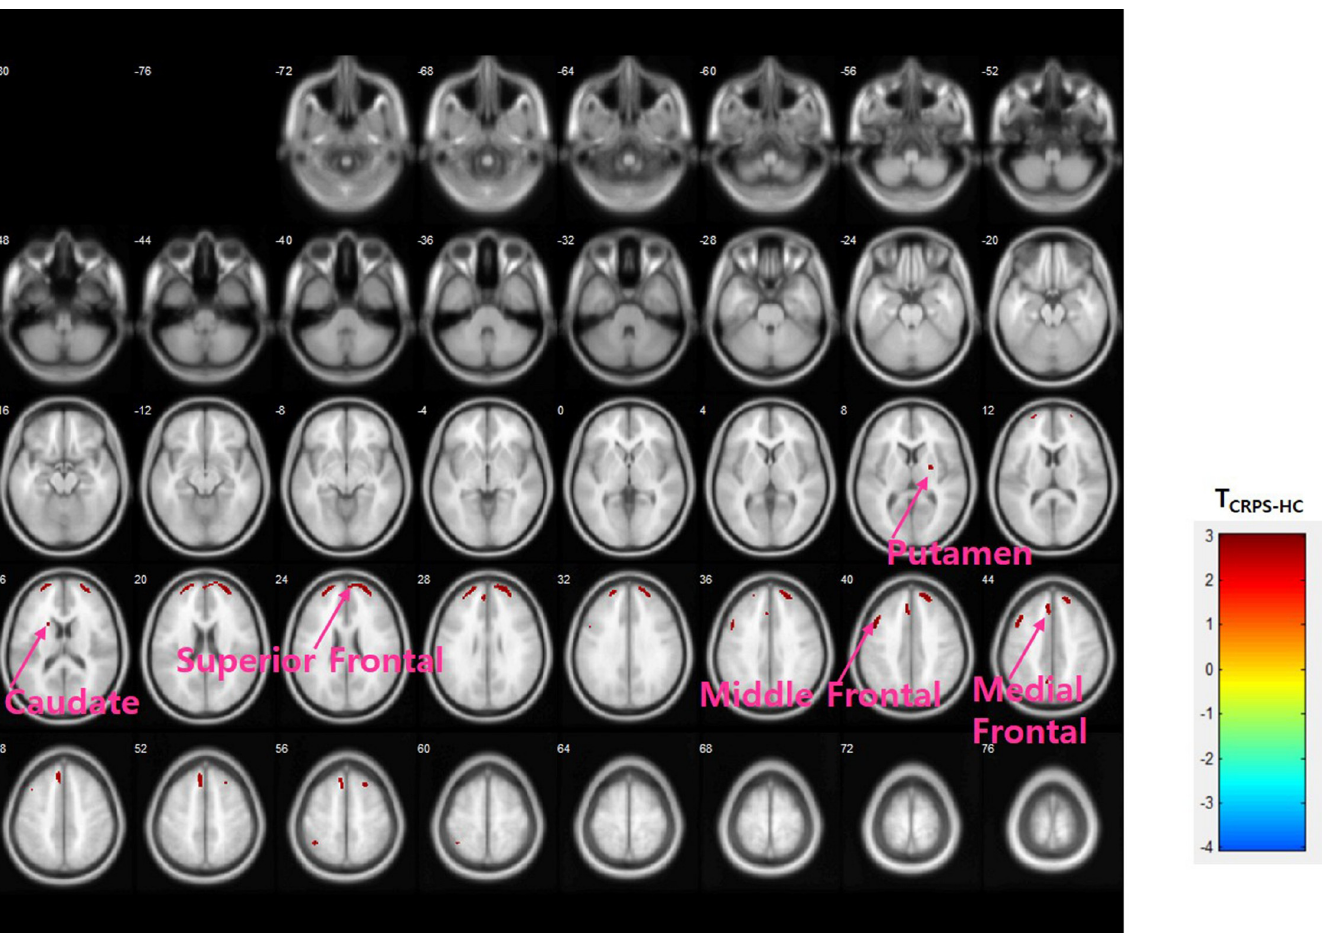
Fig 2. Differences in [ 11 C]-(R)-PK11195 DVR between CRPS patients and healthy controls. Analysis of covariance (ANCOVA) with duration covariate, uncorrected p < 0.01. other hand, higher binding levels in the CRPS group were observed in the medulla, left insula, left thalamus, left superior temporal gyrus, the right and left putamen, and the right and left medial orbital gyri compared to that of the FM group (p < 0.01) (Fig 3). Additionally, ROI analysis revealed higher [ 11 C]-(R)-PK11195 binding in the right and left thalamus (p = 0.023, p = 0.008) right and left putamen (p = 0.008, p = 0.046), right and left caudate (p = 0.012, p = 0.029), right and left caudate head (p = 0.005, p = 0.034) and right globus pallidus (p = 0.037) of CRPS patients compared with that of the FM group. Correlations between neuroinflammation and psychological symptoms in FM patients In patients with FM, there were positive correlations between the DVR of [ 11 C]-(R)-PK11195 in the left medial frontal (r = 0.584, p = 0.046), left superior parietal (r = 0.681, p = 0.015) and left amygdala (r = 0.655, p = 0.021) and the affective pain score (MPQ-A) (Fig 4A). In patients with FM, there were positive correlations between the DVR of [ 11 C]-(R)-PK11195 in the left medial frontal (r = 0.699, p = 0.011), left superior frontal (r = 0.641, p = 0.025) and left amyg- dala (r = 0.808, p = 0.001) and SRI stress scores (Fig 4B). Furthermore, the DVR of [ 11 C]-(R)-